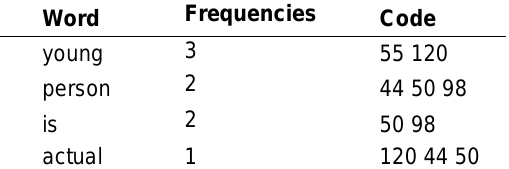
Table 3: Words with their corresponding codes